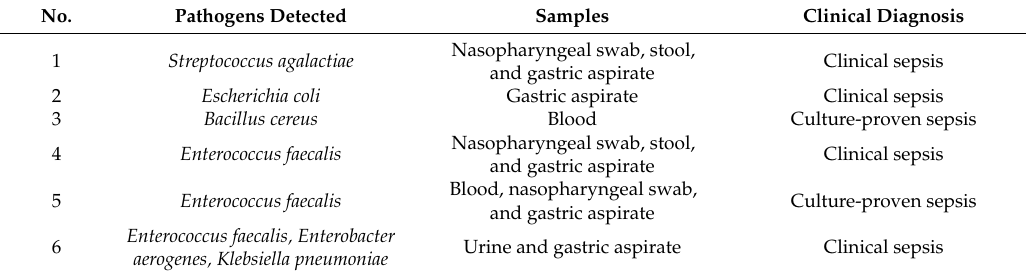
Table 2. Pathogens detected and samples used for culture among preterm infants in the confirmed diagnosis